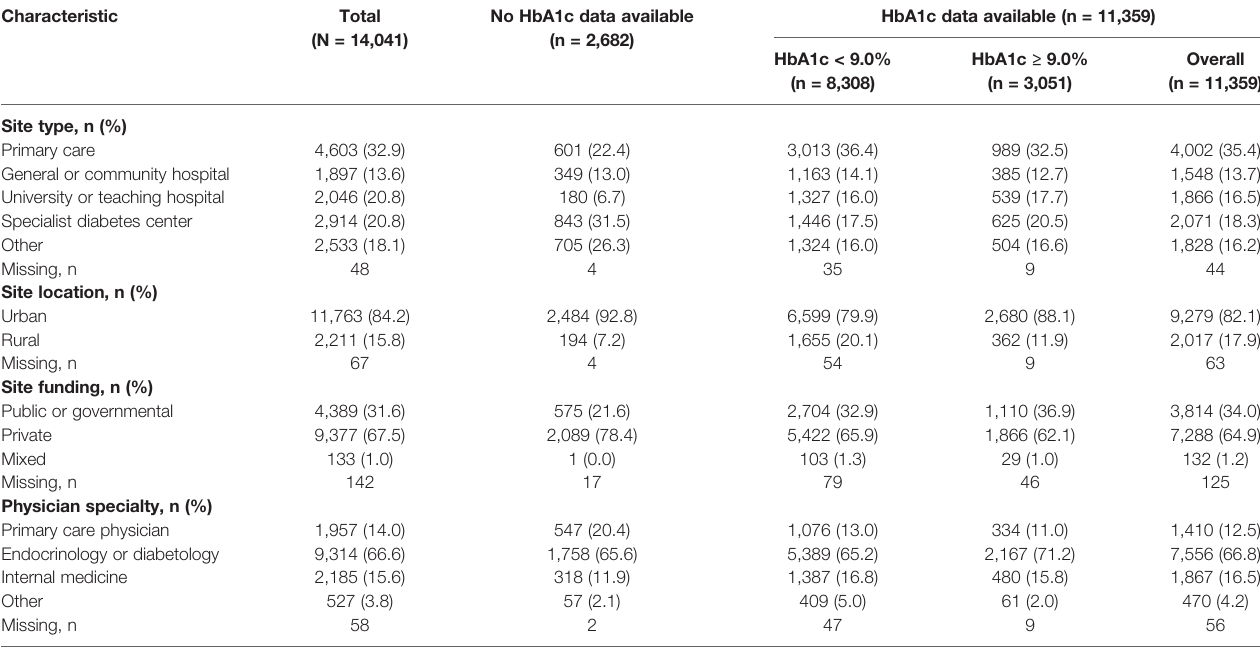
TABLE 2 | Physician and site characteristics of DISCOVER study participants overall, and with and without an available baseline HbA1c measurement.